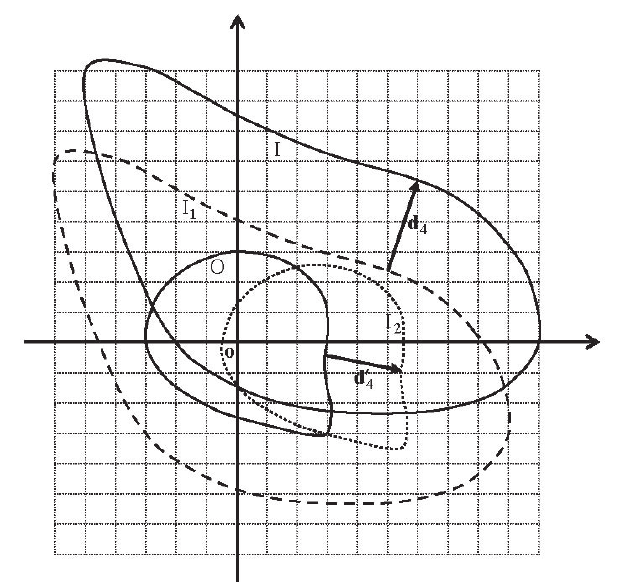
Figure 3 Affine magnification of object O by Y to image I. It is equivalent to magnification by Y to intermediate image I followed by magnification Y 1 30) to I. It is also equivalent to magnification by Y 31) to I followed by magnification by Y 2